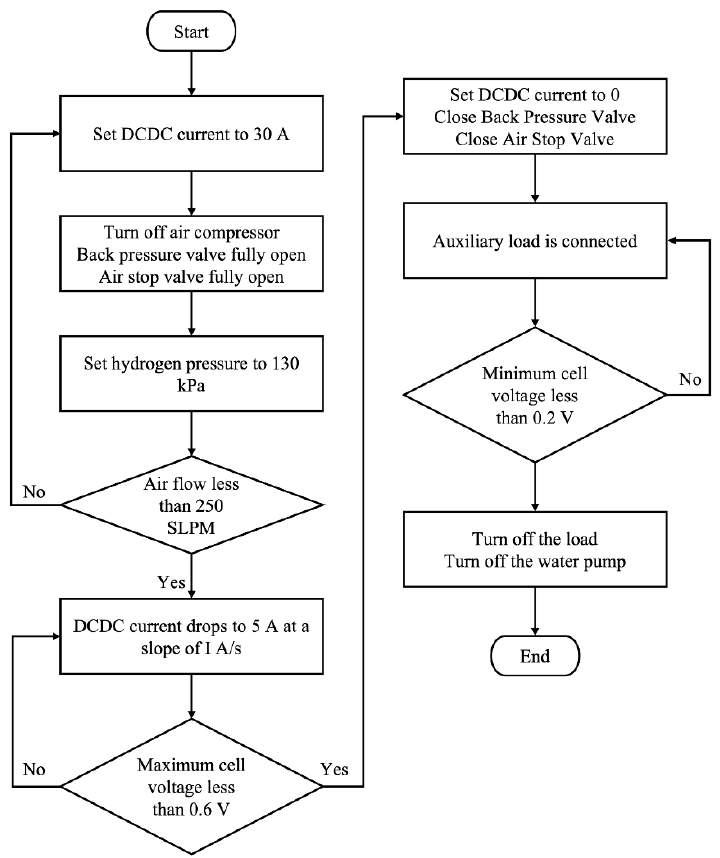
Figure 3. The experimental flow chart of optimized shutdown strategy.